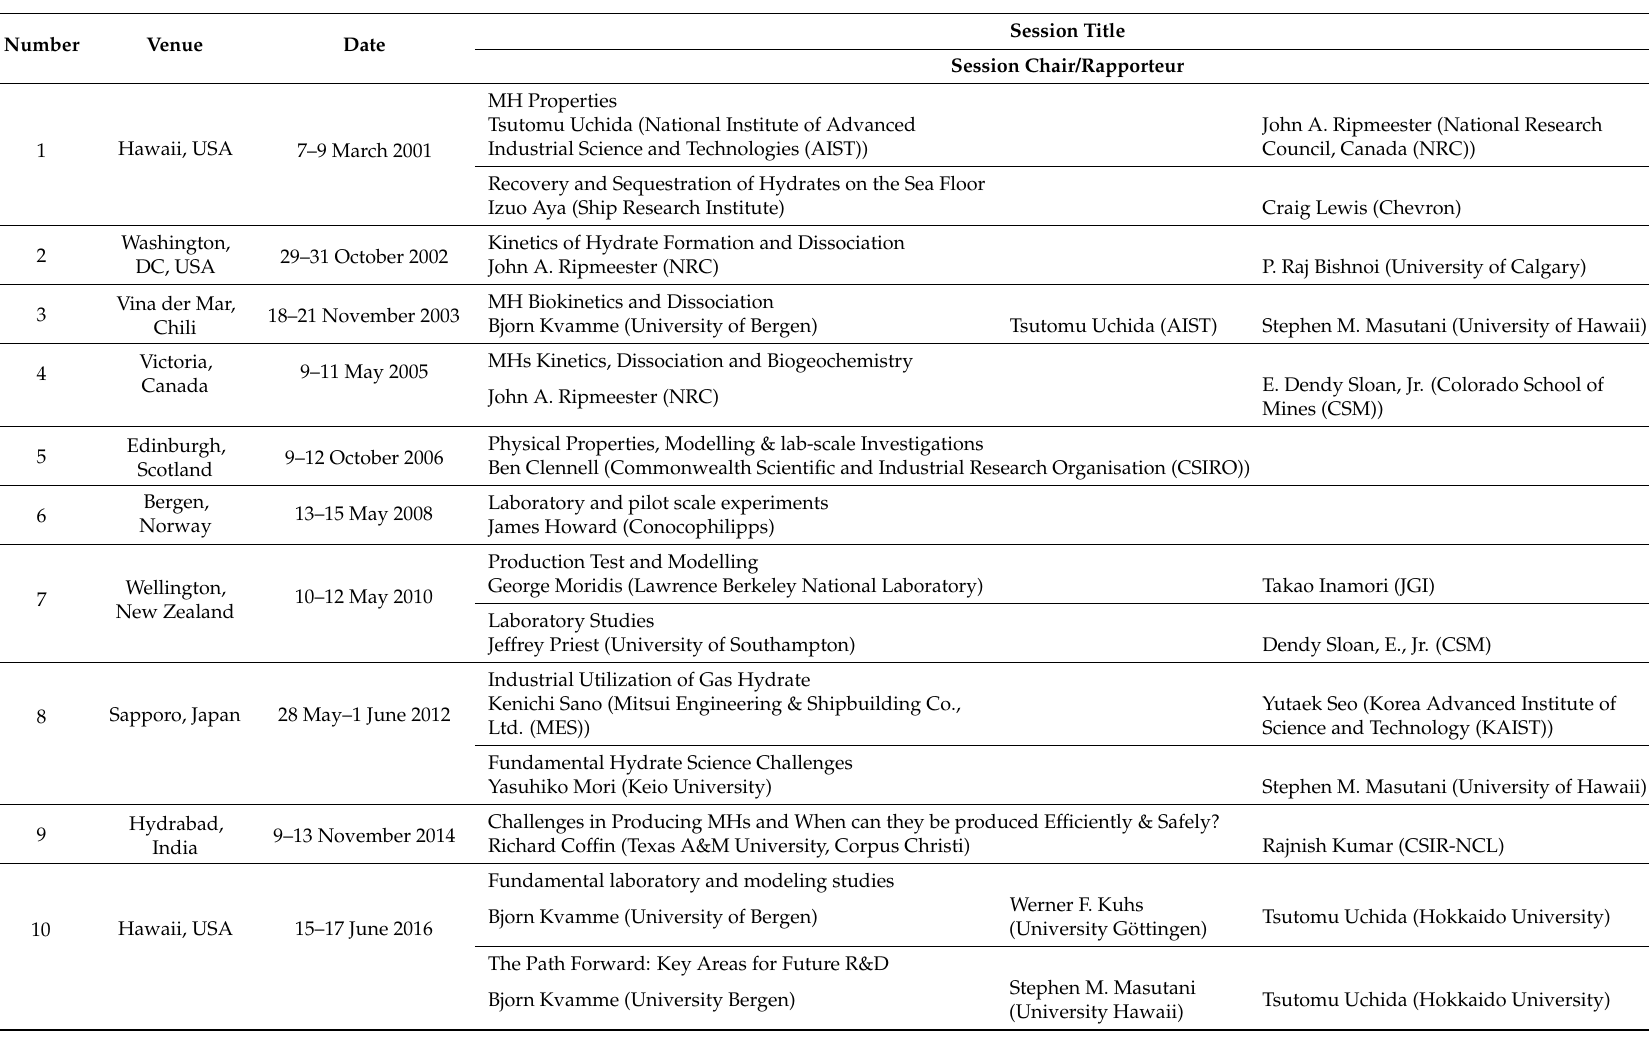
Table 1. Title and chairs of breakout sessions on the topics of the fundamental properties of gas hydrates in each Fiery Ice Workshop. MH: Methane Hydrate.